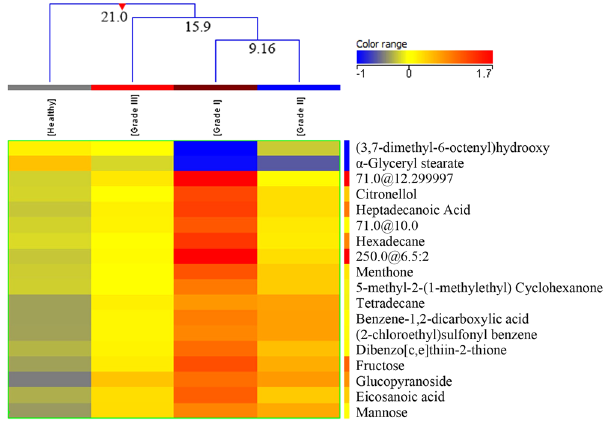
Figure 2. Dendogram showing comparison of four groups of samples i.e. healthy controls, grade. I, II and III of Breast Cancer patients using normalized intensities of eighteen significant metabolites (p < 0.05). The dendogram was constructed by applying a hierarchical clustering algorithm (Canberra, absolute distance metric, complete linkage). Compounds that have been identified have their name mentioned while unidentified compounds are recognized by their retention